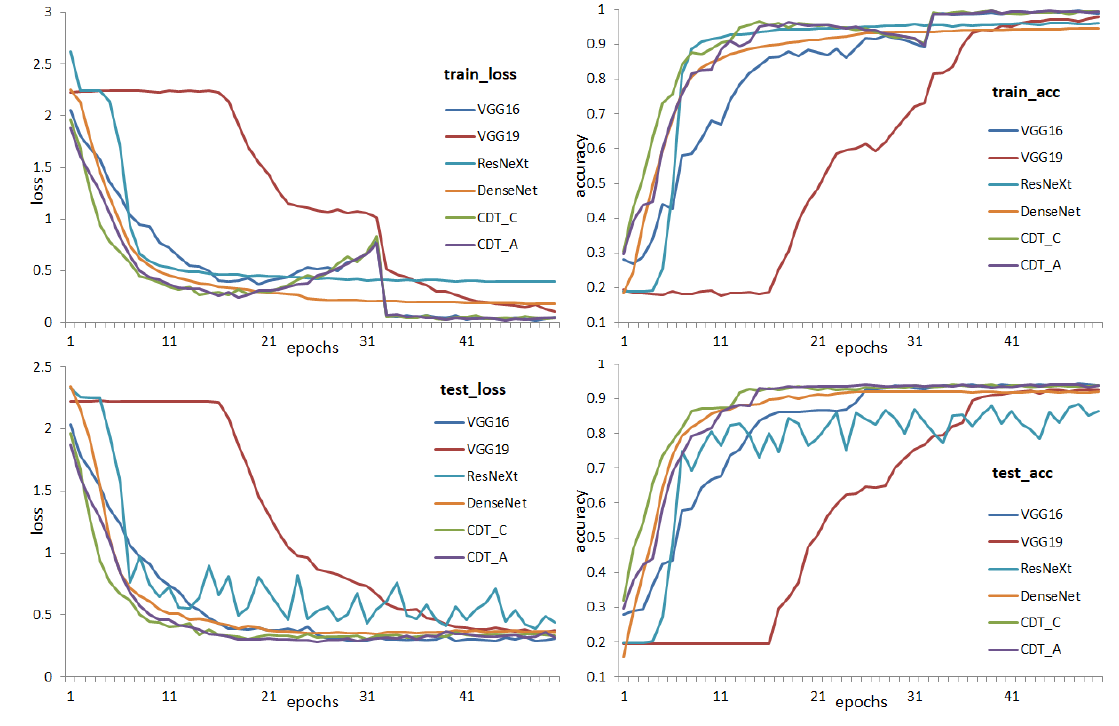
Figure 8. Compared results on SVHN.